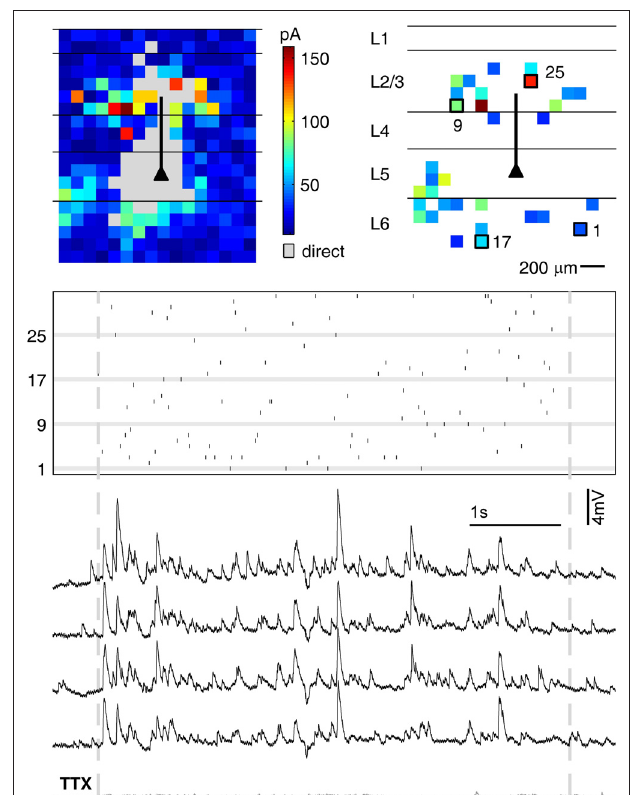
FIGURE 4 | Testing reliability of signal propagation and postsynaptic integration with dynamic photo stimulation. The functional maps show the complete scan of the tissue (left panel) and the selected locations (right panel) used for dynamic stimulation of the postsynaptic cell (marked by a triangle). The spatio-temporal stimulation pattern generated with those presynaptic locations (indicated by the raster plot below, where each line corresponds to one presynaptic location, while tics mark activation times) was applied several times during recording from the same postsynaptic cell (black traces). To control if, as intended, direct stimulations of dendrites were omitted during DPS, TTX was applied after the experiment, and the stimulation pattern was applied again with presynaptic action potentials blocked. The absence of postsynaptic potentials under TTX (gray trace) confi rmed that no location covering dendrites of the postsynaptic cell was included in the stimulation